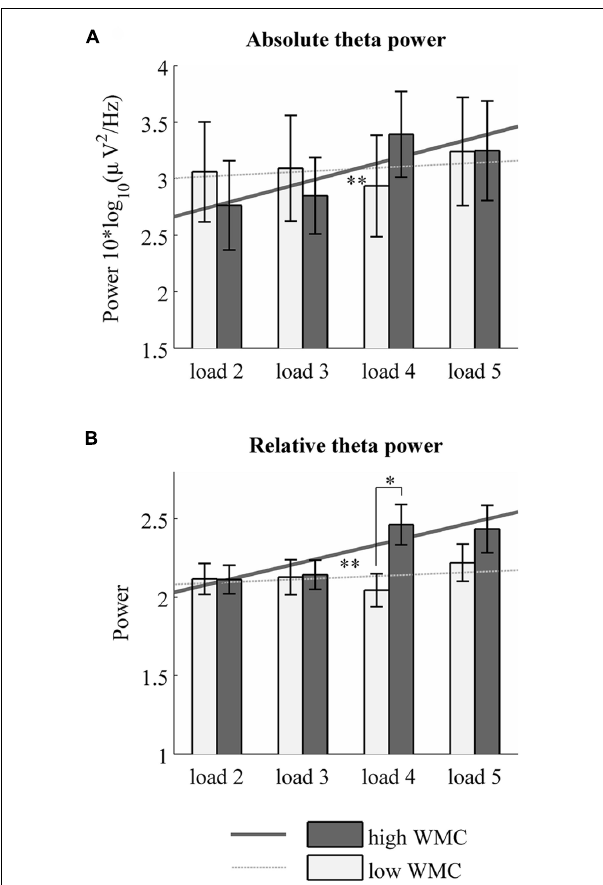
FIGURE 2 |Absolute and relative theta power in each memory load for low and highWMC groups. Mean 4–6 Hz absolute (A) and relative (B) theta power over frontal electrodes in high and lowWMC groups. ∗ p < 0.05, ∗∗ p < 0.01.